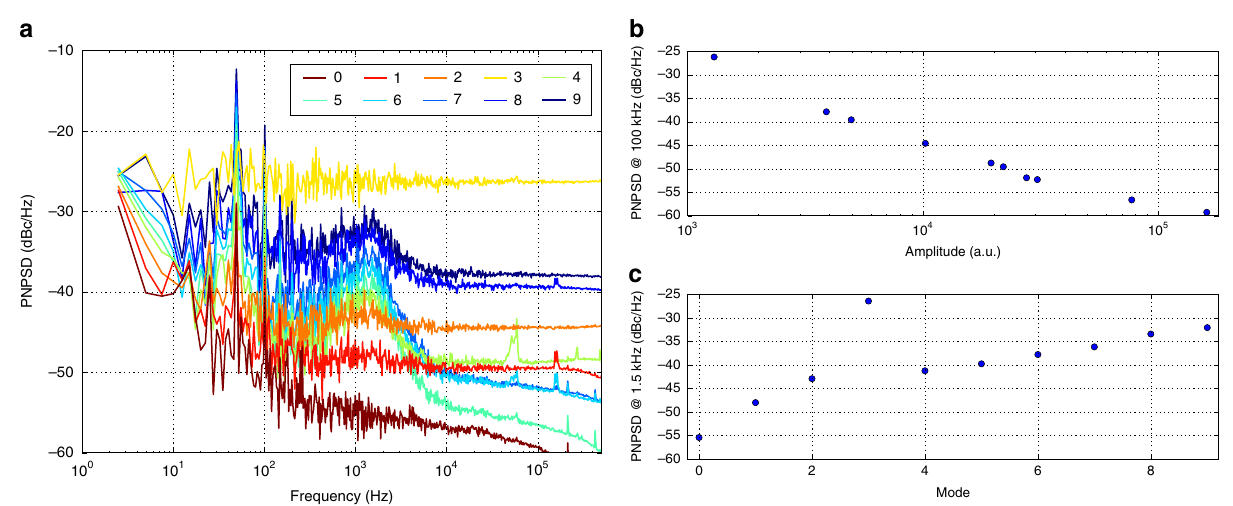
Fig. 6 Phase Noise Power Spectral Density analysis. Simultaneous retrieval of the PNPSD of the beat-notes from the Fourier-transform spectra of the RF- comb in 2-second-long acquisitions (see Fig. 3a). a PNPSD of modes from 0 to 9, smoothed with an exponential law. b PNPSD level dependence on the amplitude of the modes at 100 kHz. c PNPSD dependence on the order of the modes at 1.5 kHz, corresponding to the excess noise